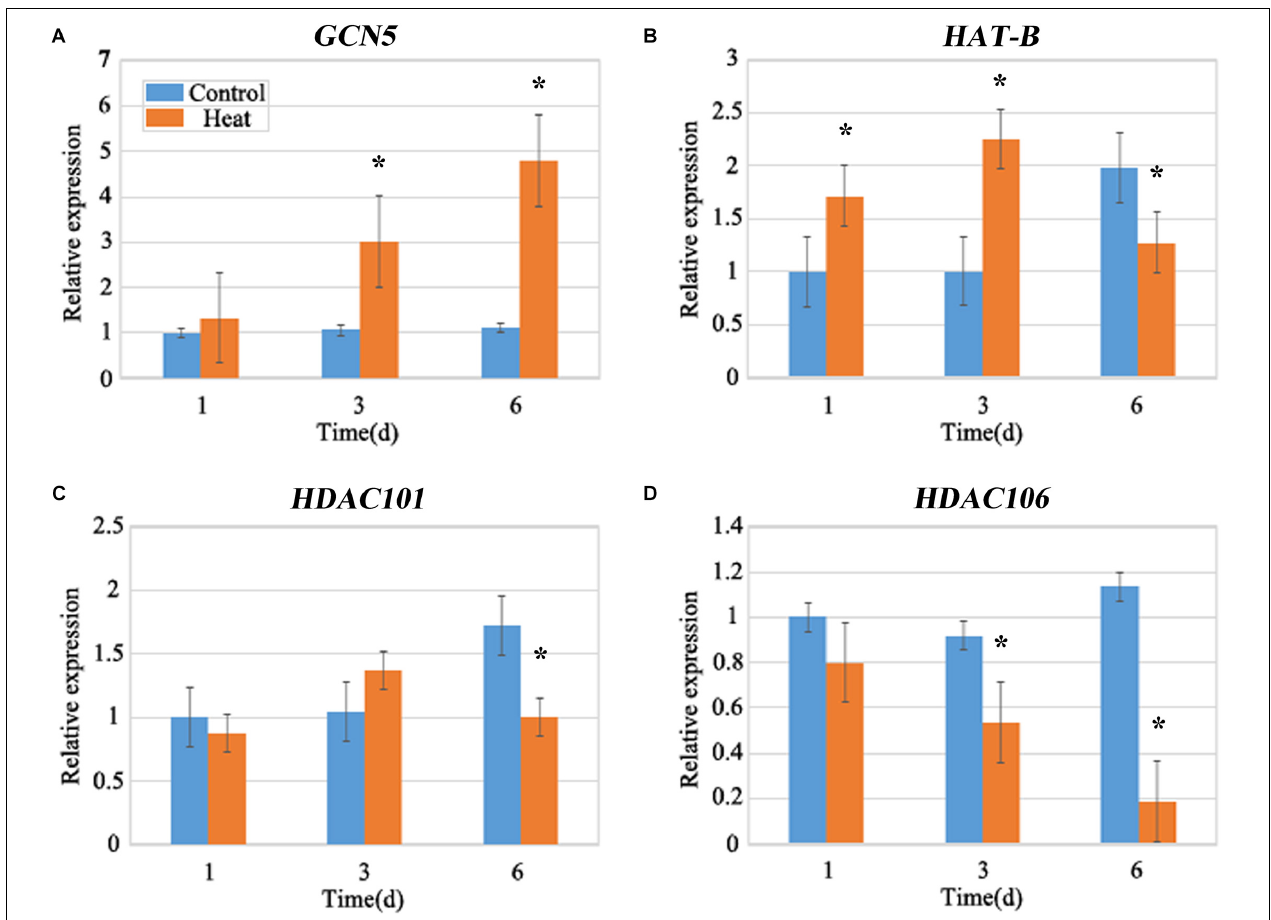
FIGURE 3 | Quantitative Fluorescence PCR analysis. The expression levels of the maize histone acetyltransferase ( HATs ), GCN5 (A) , HAT-B (B) , and histone deacetylase ( HDACs ), HDAC101 (C) and HDAC106 (D) under heat stress. The expression of HATs , GCN5 and HAT-B were up-regulated, and the expression of HDACs , HDAC101 and HDAC106 showed a decreasing trend under heat treatment for 1–6 days. The gene expression level of 1 day in the control group was set as 1. Actin is a standardized internal reference y. Each experiment was repeated three times. Asterisk ( ∗ ) indicated that the gene expression level of the heat treatment group which was found to be significantly different from that of the control group ( t- test, p <